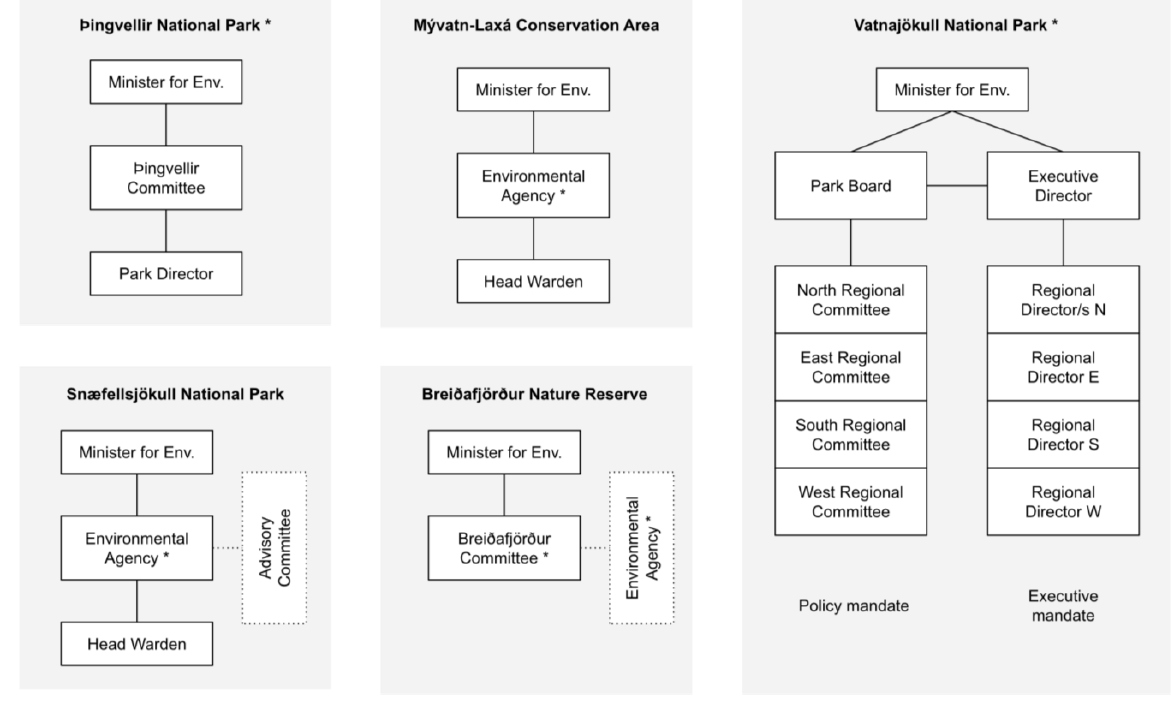
Figure 3. The governance system structures for the selected PAs (Vatnajökull NP [11] ).